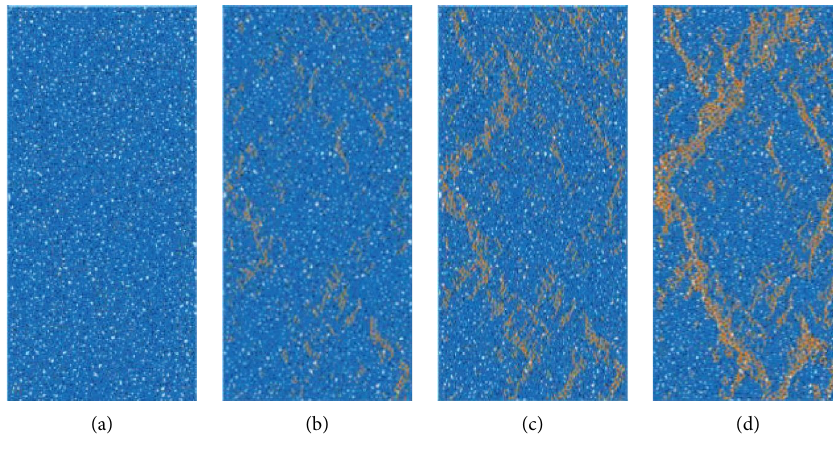
Figure 6: The simulation process of the triaxial compression